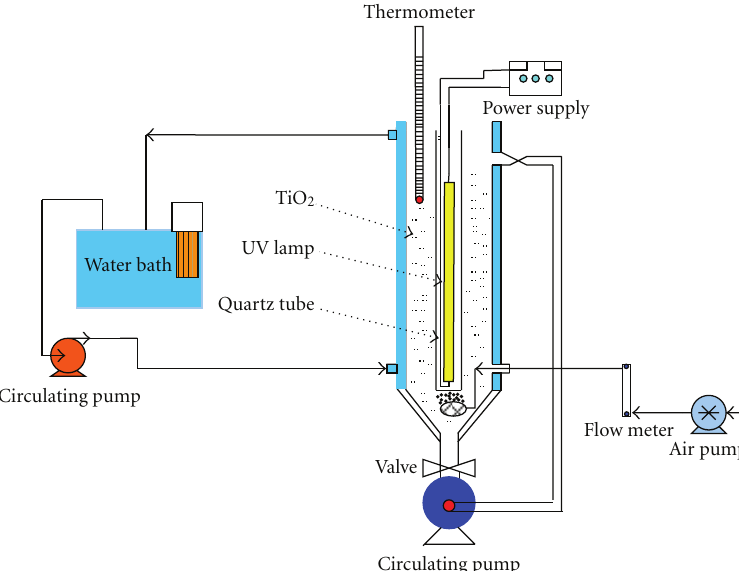
Figure 1: Experimental setup of